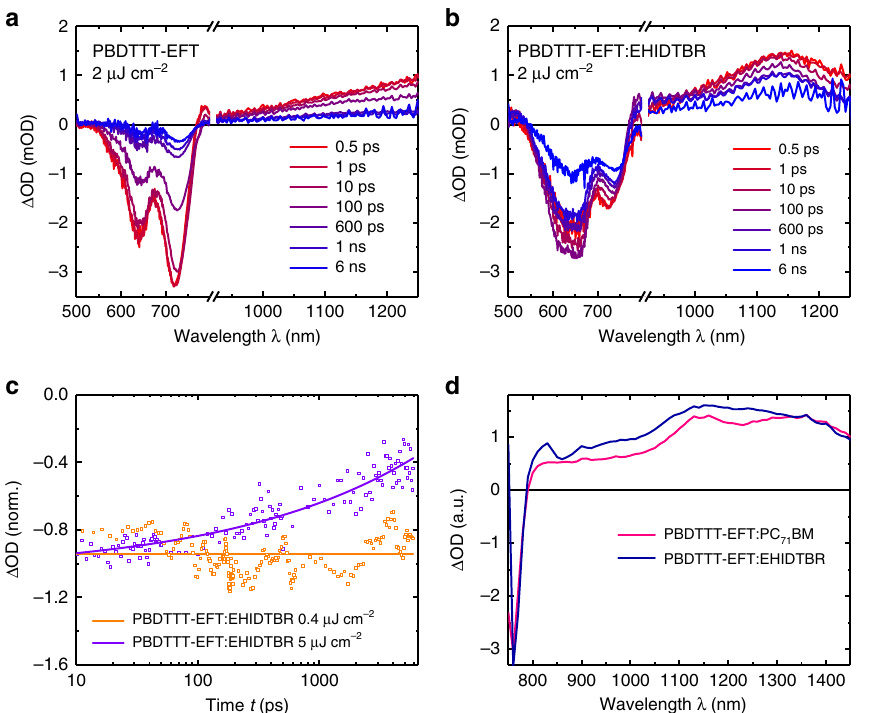
Fig. 2 Spectroscopy data showing fast exciton dissociation and ef fi cient polaron formation. Transient absorption spectra for a ( a ) neat PBDTTT-EFT fi lm and ( b ) PBDTTT-EFT:EHIDTBR blend fi lm, following excitation of the PBDTTT-EFT at 500 nm. Spectra are shown as a function of time delay after excitation from 0.5 ps to 6 ns. c The blend decay dynamics at 730 nm as a function of excitation density. At low excitation densities (0.4 µ J cm − 2 ), no decay is apparent, indicative of an absence of geminate recombination dynamics; at higher excitation densities (5 µ J cm − 2 ), signi fi cant decay is observed on this timescale (up to 6 ns) indicative of bimolecular, non-geminate recombination losses. These non-geminate recombination losses are also apparent as an absorbance loss at long time delays in b (measured at 2 µ J cm − 2 ). d Photo-induced absorption spectra of PBDTTT-EFT:PC 71 BM and PBDTTT-EFT:EHIDTBR excited at 532 nm and recorded under vacuum of 10 − 6 Torr and a temperature T = 10 K illustrating the polaron yield of PBDTTT-EFT:EHIDTBR compared